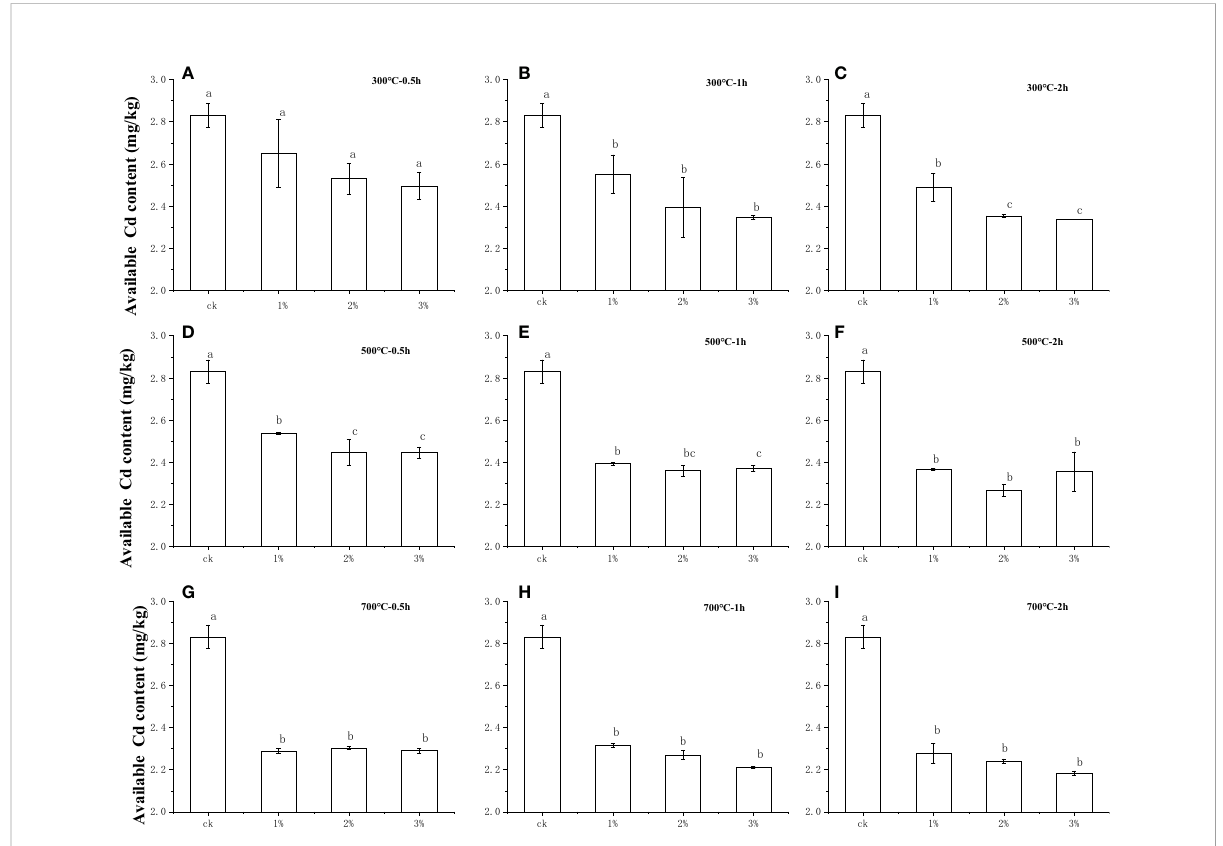
FIGURE 3 Comparison of available Cd concentration of soil by water hyacinth biochar application with different condition preparations. Small letters indicates signi fi cant